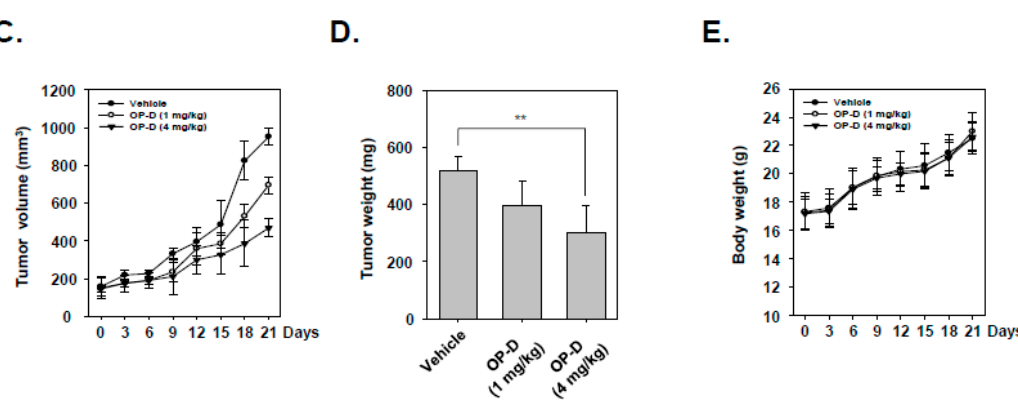
Figure 6. Antitumor effects of OP-D in xenograft mouse model. ( A ) A schematic representation of experimental protocol described in “Materials and Methods.” ( B ) Necropsy photographs of mice bearing subcutaneously implanted with a non-small cell lung carcinoma (NSCLC) tumor. ( C ) Tumor volumes in mouse measured during experiment (n = 7). ( D ) Tumor weight was measured at the end of the experiment. ( E ) Body weight changes of mice were measured at indicated times. Data represent the mean of seven measurements ± S.D., ** p < 0.01.